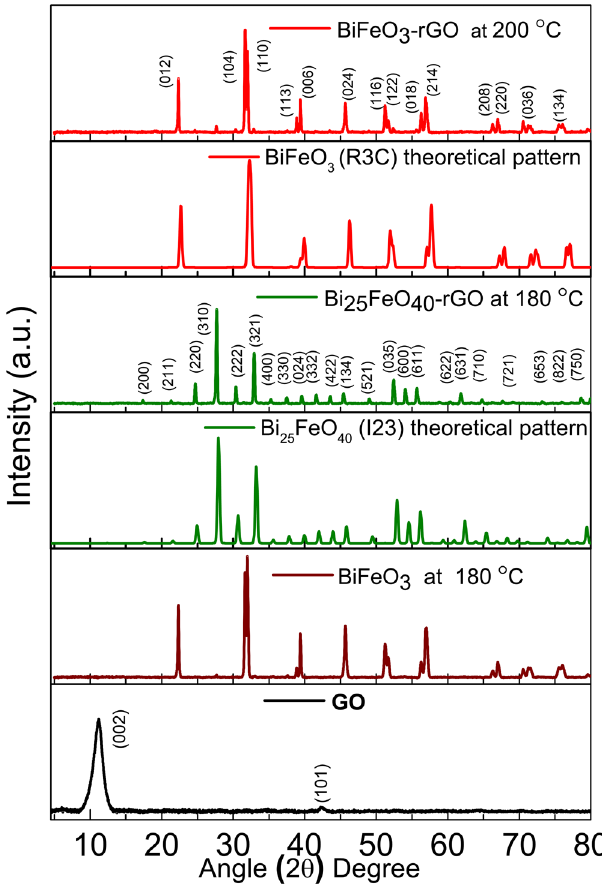
Figure 1. XRD patterns of GO, BiFeO 3 at 180 °C, sillenite Bi 25 FeO 40 -rGO at 180 °C, and perovskite BiFeO 3 -rGO nanocomposite at 200 °C. The theoretically calculated patterns for BiFeO 3 of space group R3c and Bi 25 FeO 40 of space group I23 have also been included for comparison of